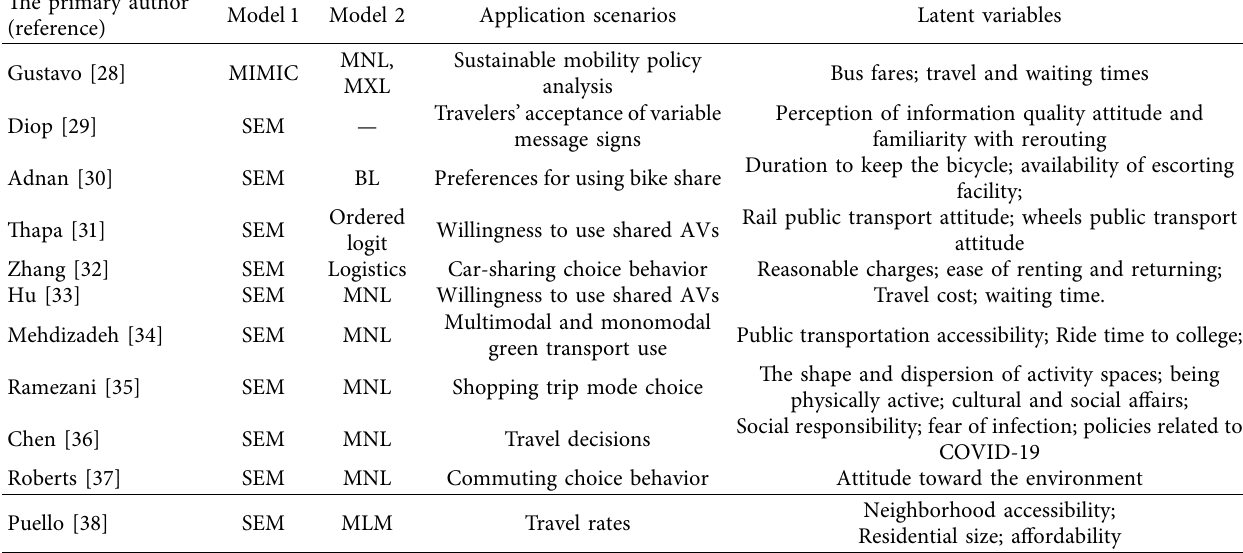
Table 1: Papers using the